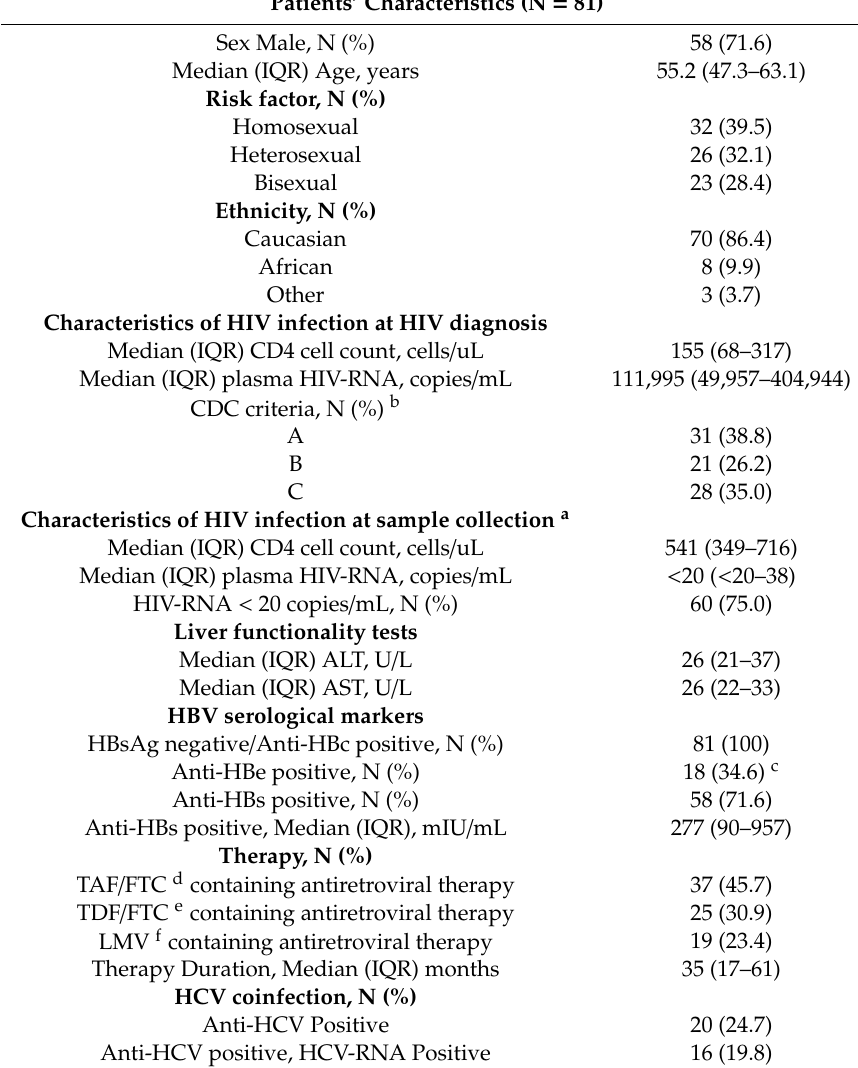
Table 1. Demographic, clinical, and virological characteristics of the study population.